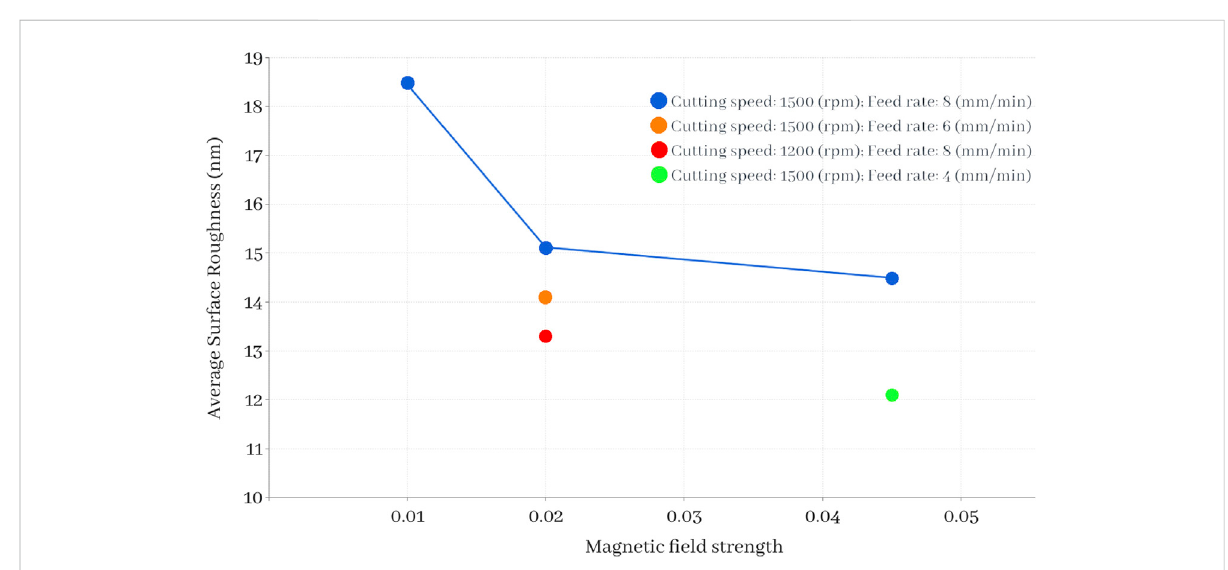
FIGURE 10 Comparing theresults oftheultra-precision SPDT of Ti-6Al-4V with minimum surfaceroughness: The magnetic fi eld intensity and theaverage of generated surface